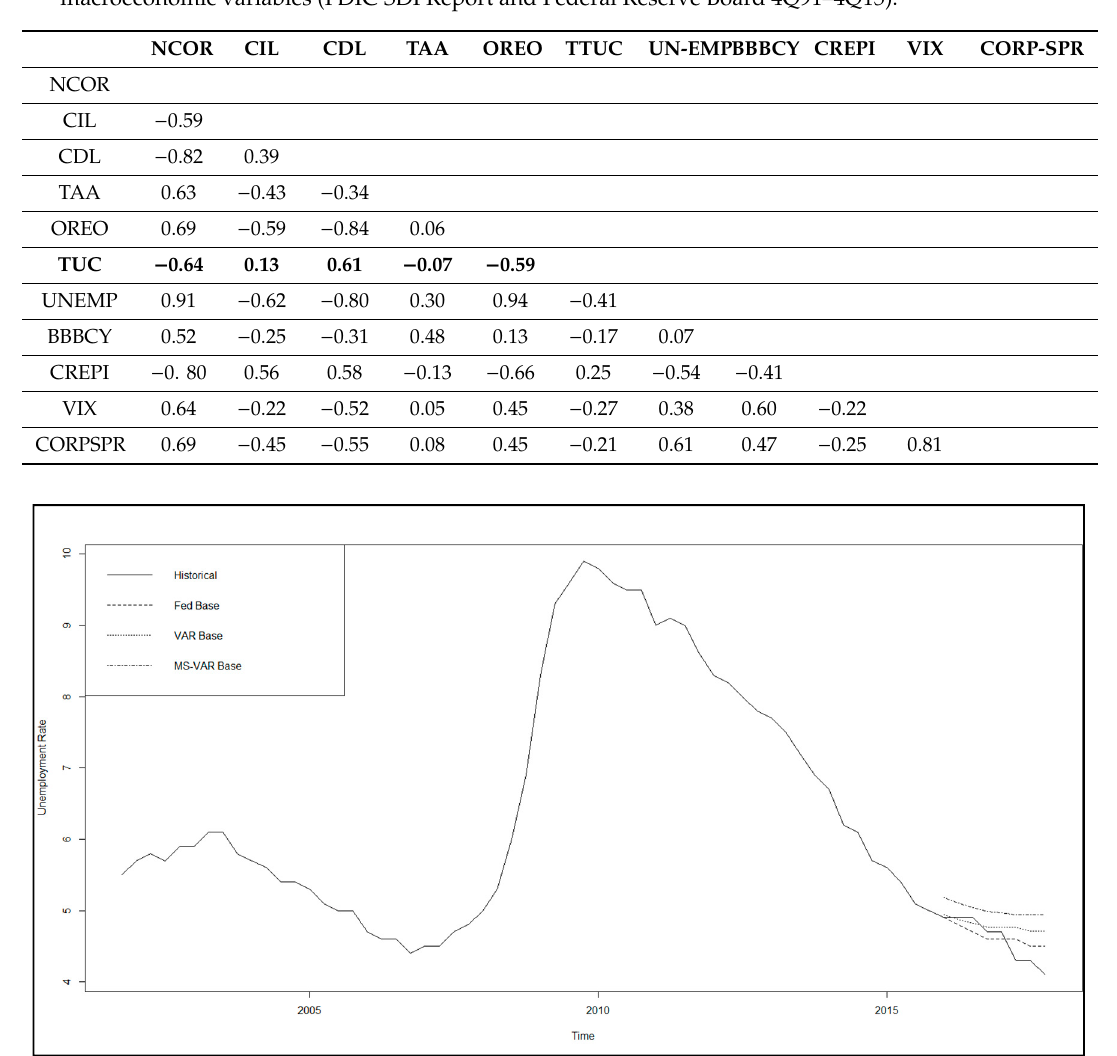
Figure 5. Time series and base scenarios—unemployment rate (Federal Reserve Board 4Q91–4Q15 and Jacobs (2018) models).